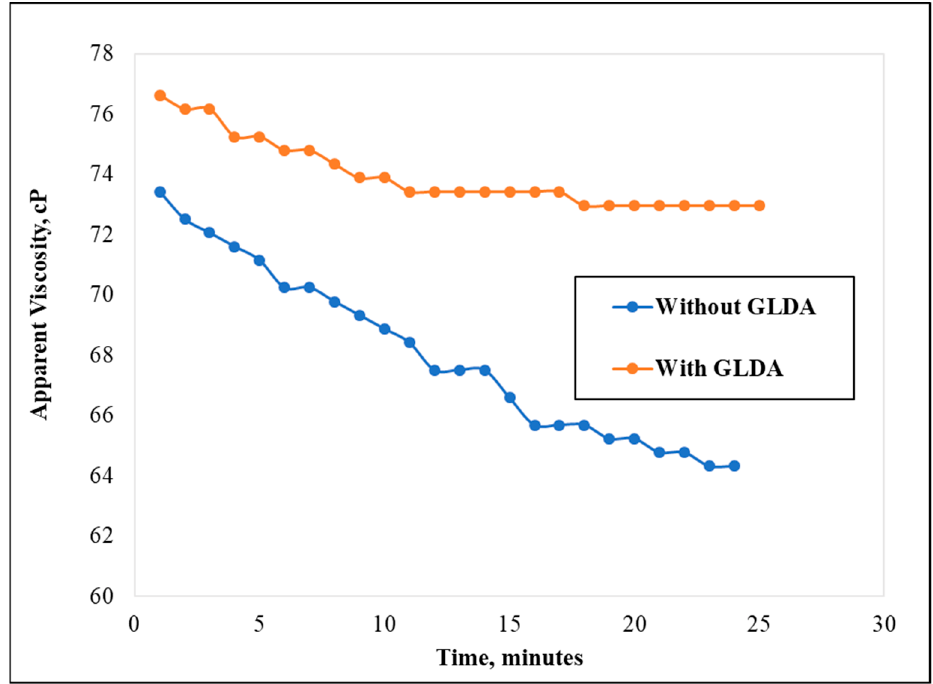
Figure 4. Viscosity measurement over time for samples with and without GLDA (temperature = 200 °F, shear rate= 100 s − 1 , pH = 8, CMHPG concentration= 50 pptg).